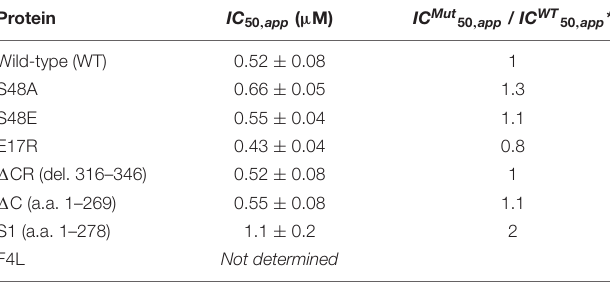
TABLE 1 | Binding affinity of wild-type and mutant TDP-43 to